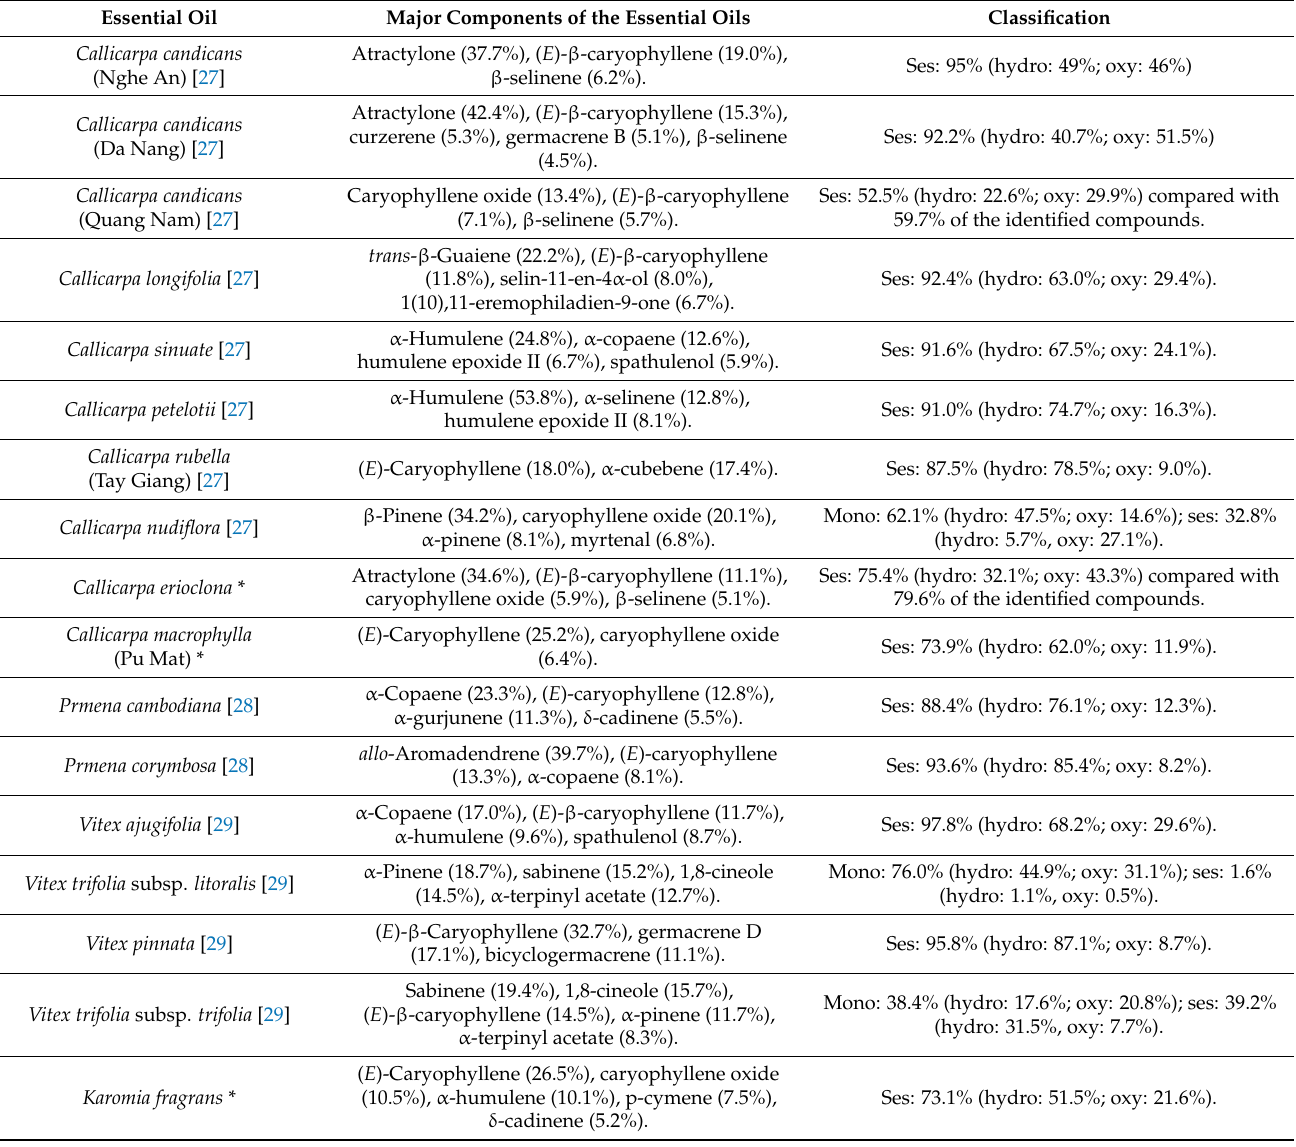
Table 1. Major components of the leaf essential oils of Callicarpa, Premna, Vitex and Karomia species from